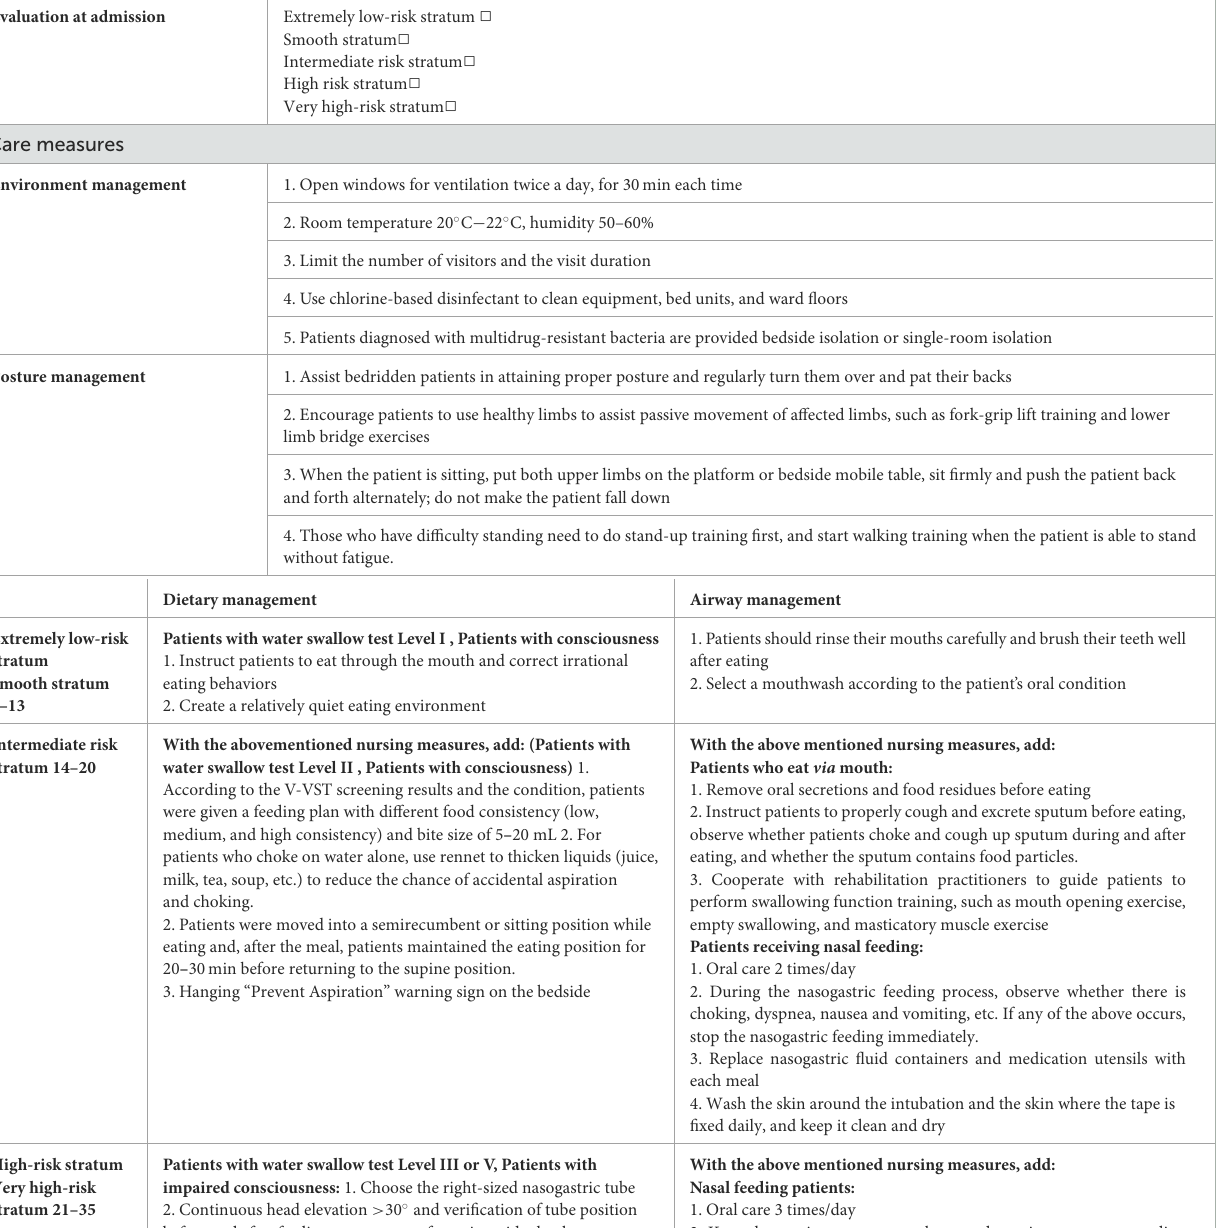
TABLE 1 Nurse-led hierarchical management care based on APS-AIS